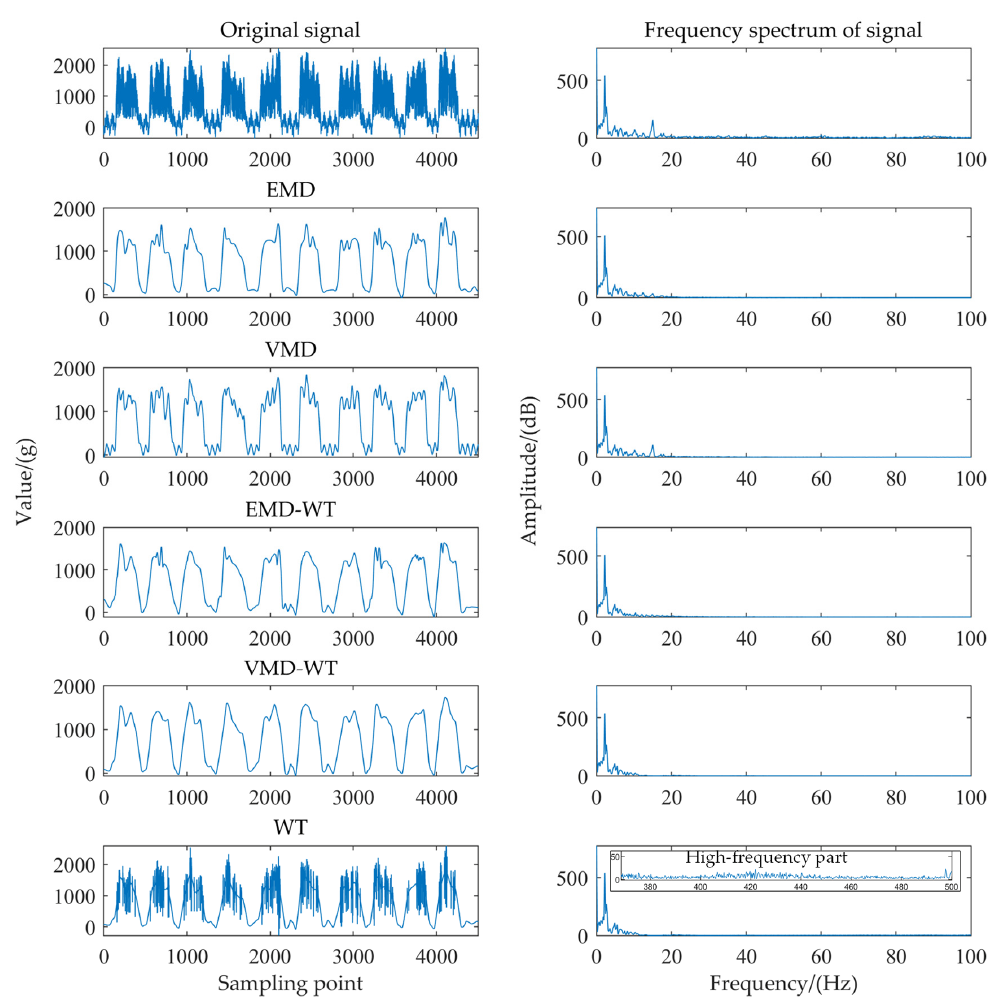
Figure 8. Frequency spectrum of the tea dynamic weighing signal with different denoising methods.